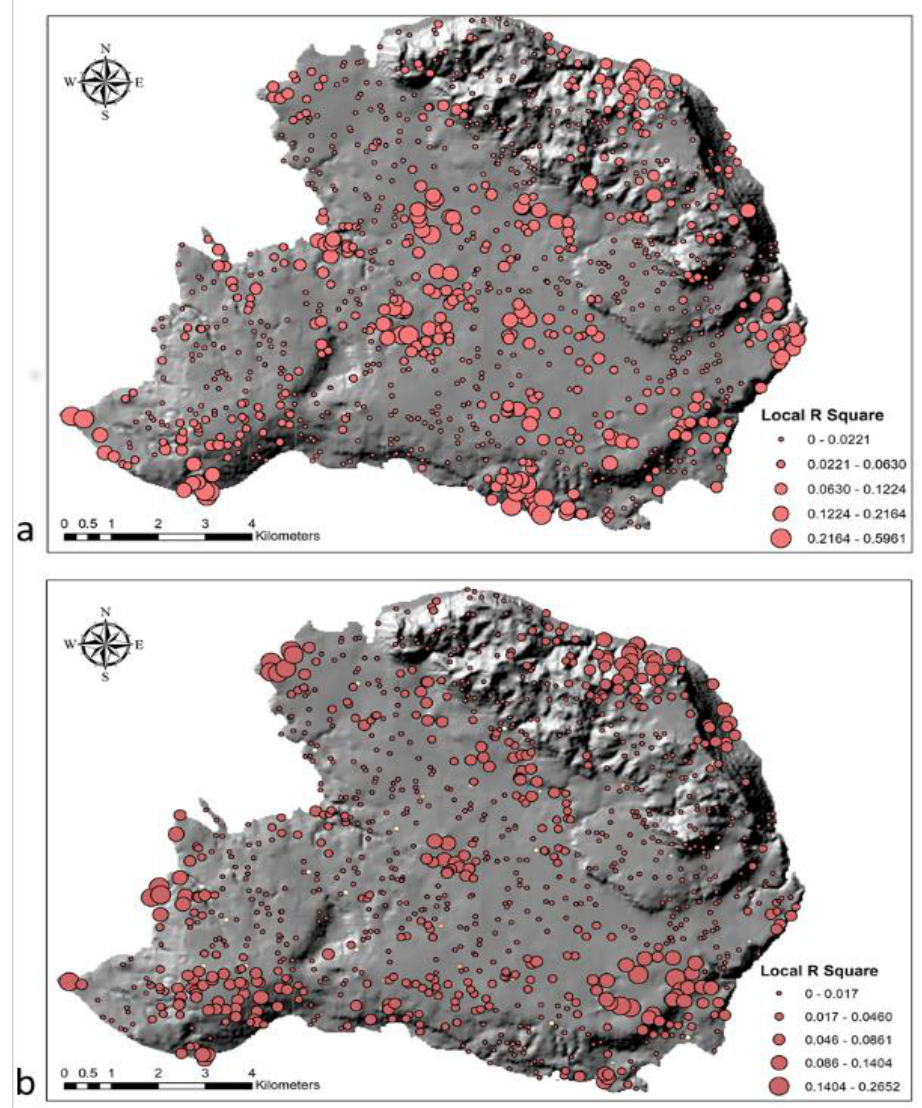
Figure 13. Spatial allocation of local R 2 values concerning the correlation between the RUSLE and the ANN satellite derived SOM for ( a ) Landsat 8, and ( b ) Sentinel-2 imageries.